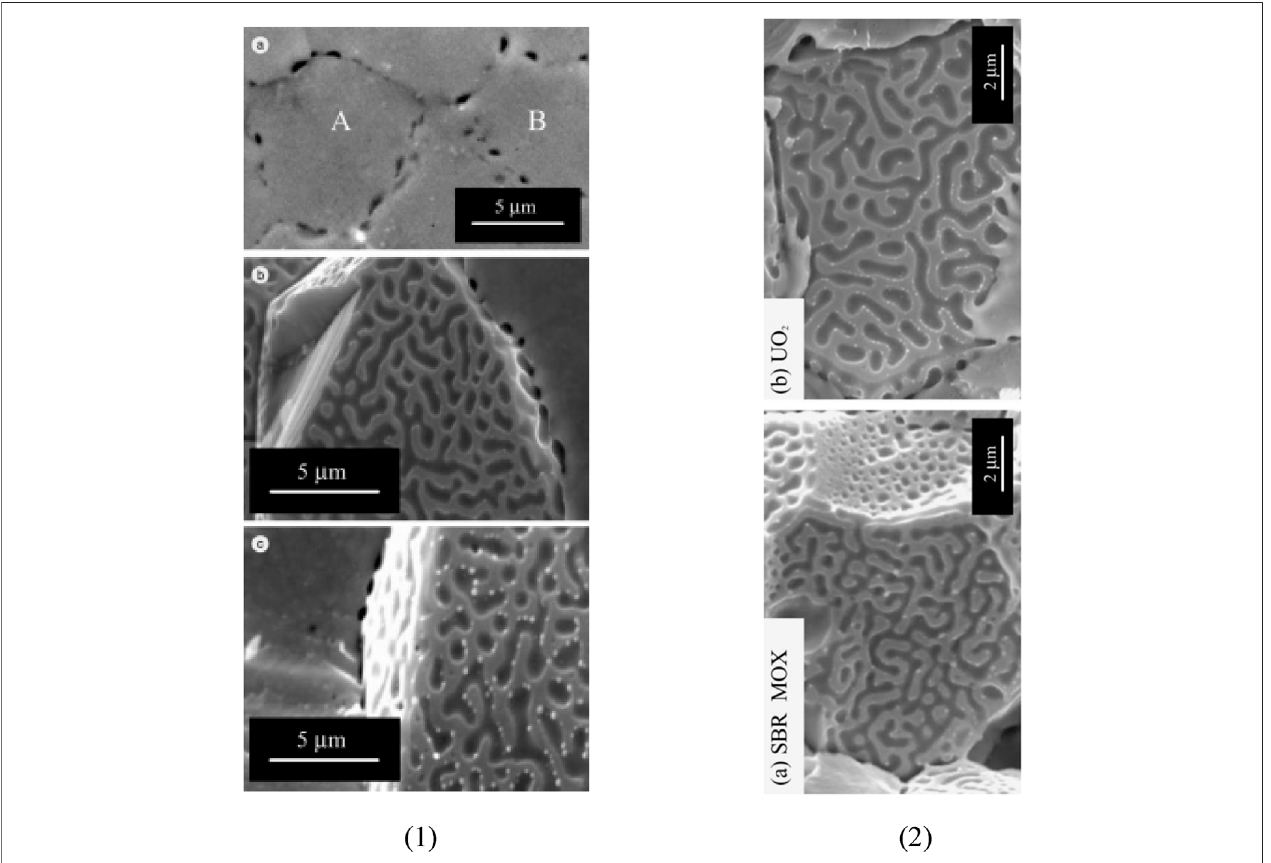
FIGURE 8 | SEM images (left) of intergranular bubbles in (1a) SBR MOX CT10 transverse polished section, (1b) grain face in an AGR (Advanced Gas-cooled Reactor) UO 2 sample which released 5.4% of the fi ssion gas inventory during annealing at 0.5 ° C/s to 1900 ° C, and (1c) grain face in an AGR UO 2 sample which released 7.4%ofthe fi ssiongasinventoryduringannealingat20 ° C/sto1700 °